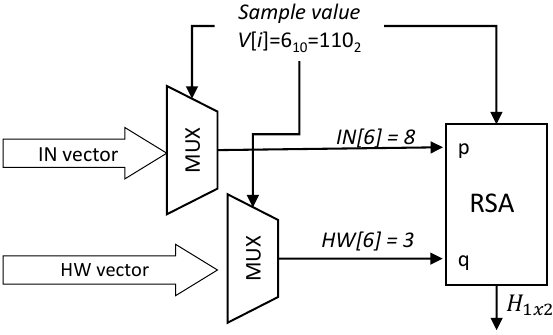
Figure 2. Example of replacement of a sample value from the number of iterations and Hamming